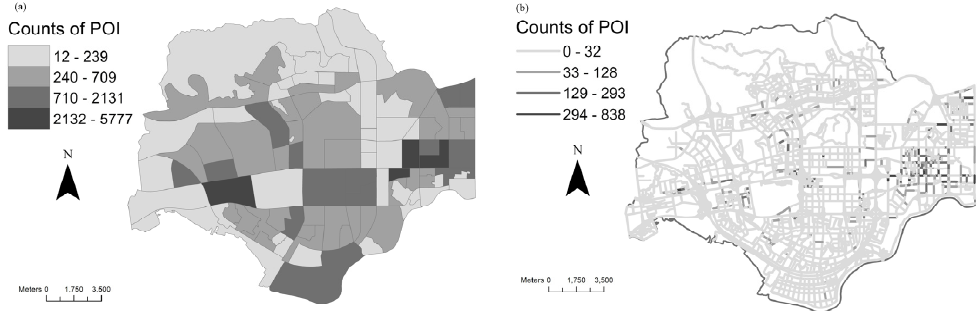
Figure 2. The base distribution in the study region: ( a ) the facility points of interest (POI) counts in 98 communities; ( b ) the POI counts for the 4372 basic spatial units (BSUs).